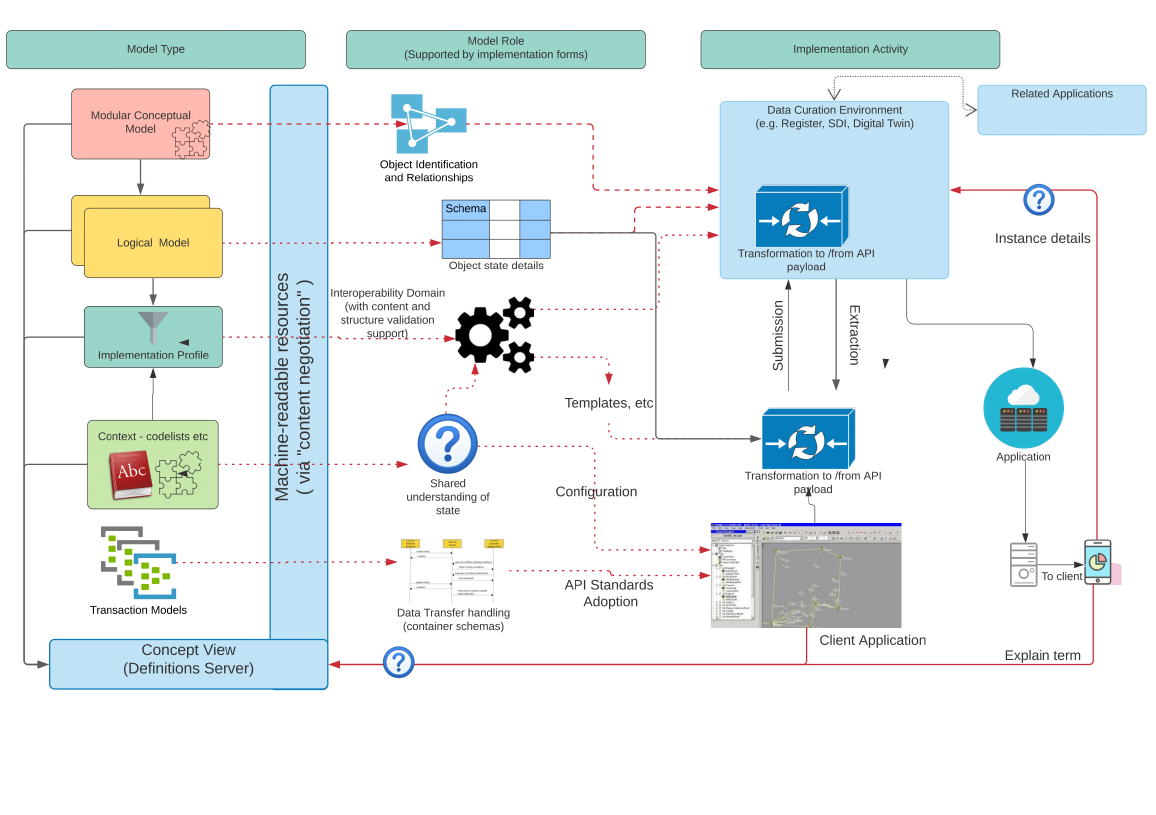
Figure 9. Example of the OGC’s FAIR approach to standards in supporting system